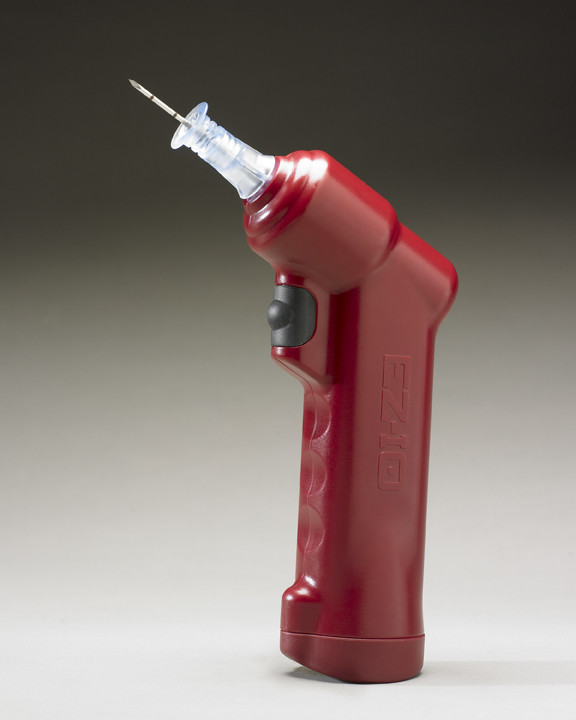
Battery driven intraosseous vascular access device (EZ-IO®, Vidacare®).